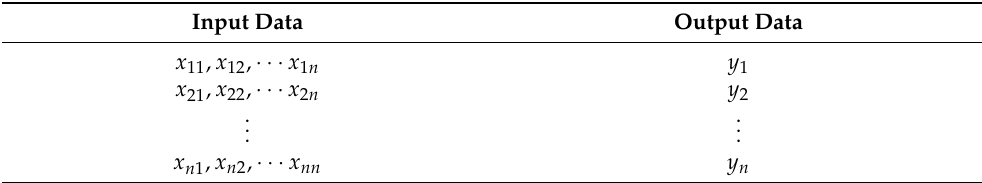
Table 6. Inputs and outputs data of network.